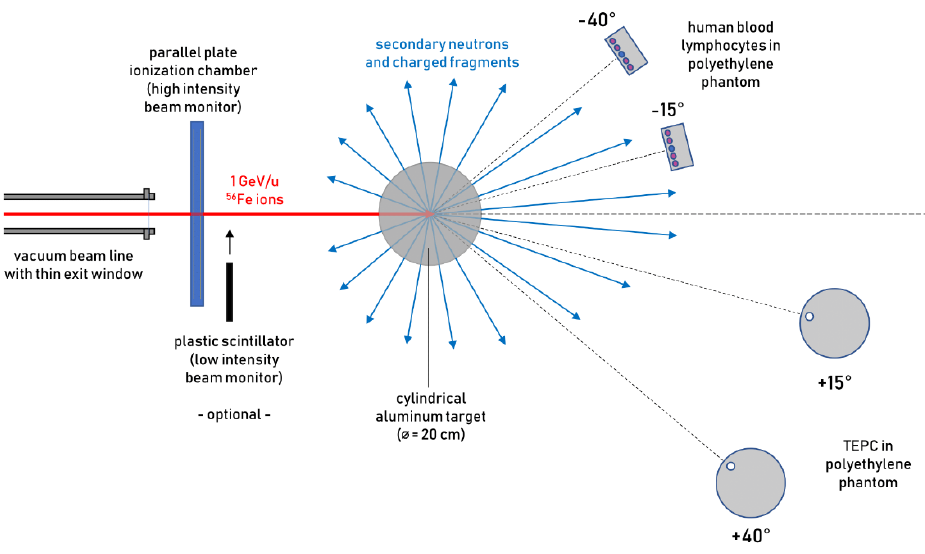
Fig. 1. Schematic of the multi-detector setup used for characterization of the secondary neutron and light ion radiation field produced by a high-energy heavy ion beam in a thick